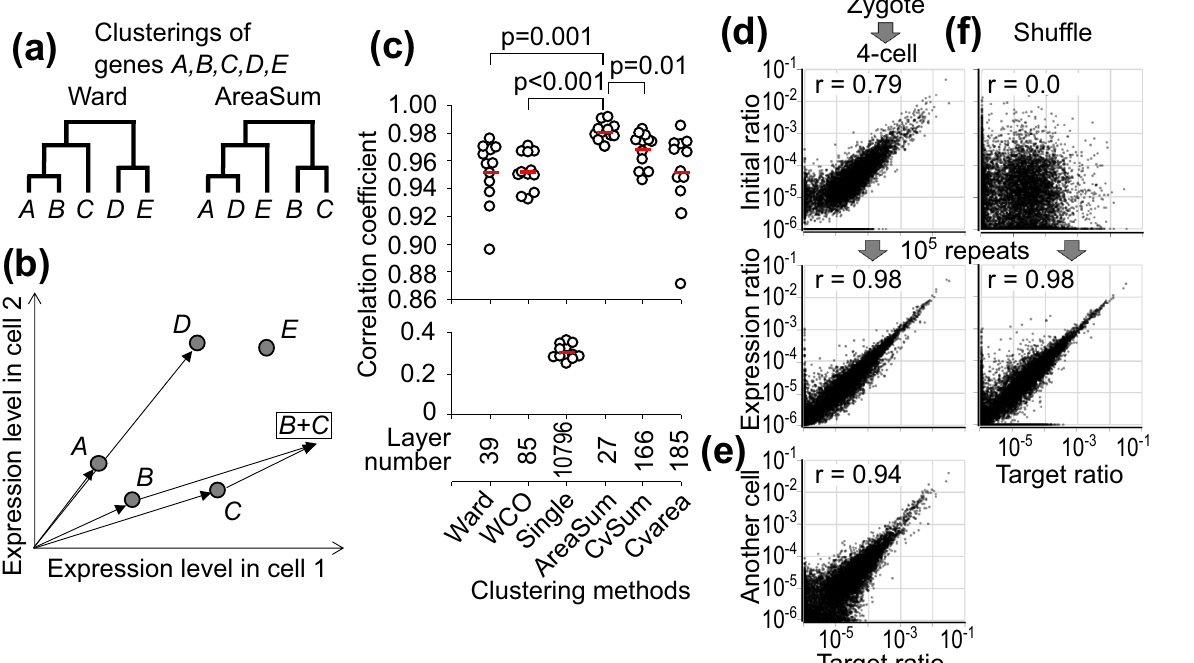
Figure 3. Hierarchical clustering of genes for the learning pair model. ( a , b ) Dendrograms ( a ) are generated using hierarchical clustering methods from the gene expression pattern ( b ). ( c ) Using the expression of 16,921 genes in 20 cells from human early embryos, 6 clustering methods generated hierarchical pairs with the indicated number of layers. In 12 tests using 3 zygote data for initial setting and 12 4-cell data for target ratio, each pair in hierarchical pairs changes the values for 10 5 repeats in the learning pair model with stepwise error. The correlations to the target ratio are shown with the mean (red bar). Paired t -test is used for statistical analysis. ( d ) Using hierarchical pairs generated with the AreaSum method and stepwise error, the change from zygote to 4-cell stage is tested. Relative expression ratios of 16,921 genes before and after 10 5 repeats are plotted against the target ratio. ( e ) Gene expression ratios from another dataset of the 4-cell stage are plotted against the target ratio using published scRNA-seq data 19 . ( f ) In the same settings in ( d ), the initial and target ratios are independently shuffled. In the dot plots, relative ratios are plotted after adding 10 −6 to all